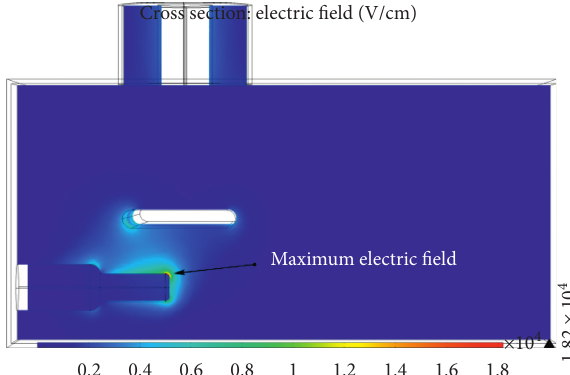
Figure 5: Electric field amplitude distribution of electric field with 608 kW input